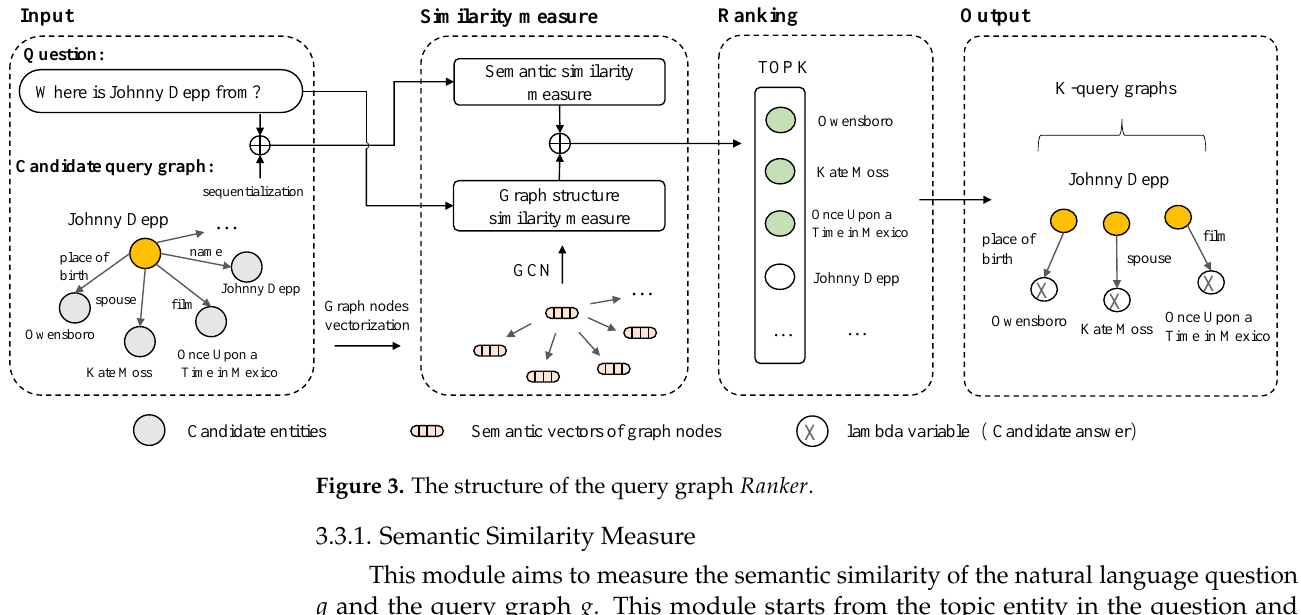
Figure 3 is an example of the query graph Ranker .